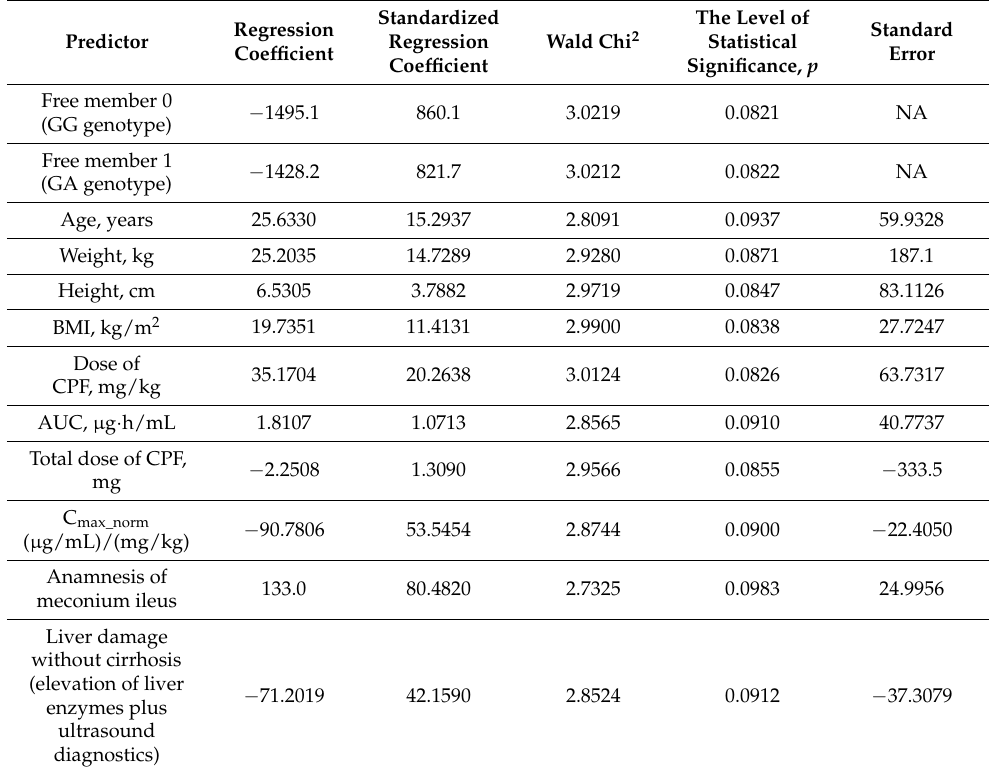
Table 9. Evaluation of logistic regression parameters in patients with different genotype variants: GG, GA, AA of the CYP2D6*4 gene (1846G > A). Standardized The Level of Regression Standard Predictor Regression Statistical Wald Chi 2 Coefficient Coefficient Significance, p